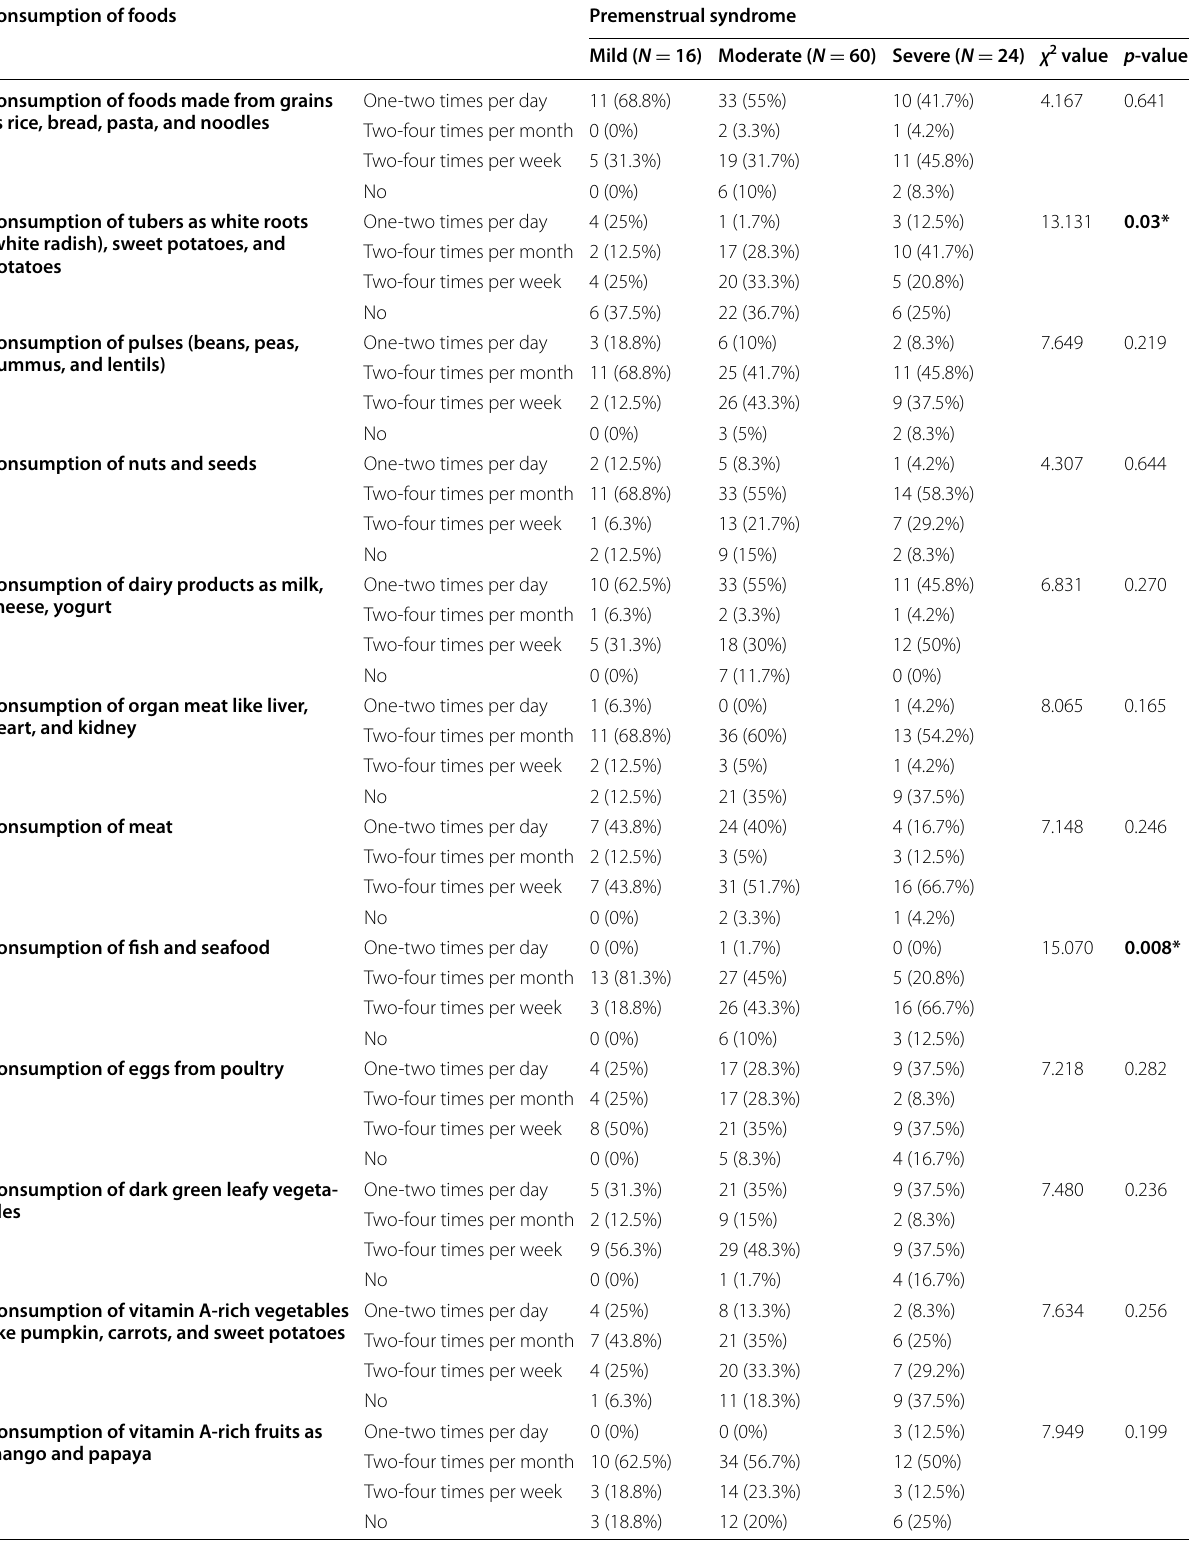
Table 3 The relationship between premenstrual syndrome severity and consumption of foods Consumption of foods Premenstrual